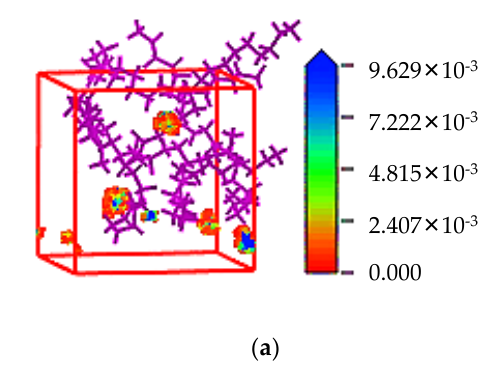
Figure 12. Density field distribution ( a ) and isopycnic ( b ) of CH 4 in PVDF containing crude oil. When the absorbed gas molecules diffuse in the polymer, they vibrate constantly.